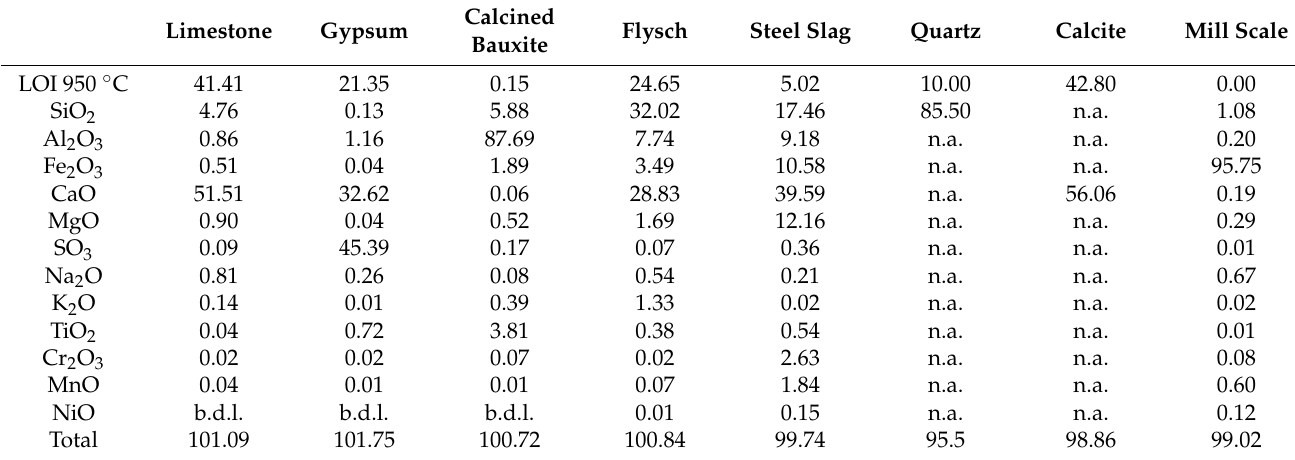
Table 1. Chemical composition of the raw materials (wt.%). The main oxides needed for the formulation of the raw mixtures were determined by wet chemistry, while the minor components were determined by X-ray fluorescence spectrometry (WDXRF, Thermo Scientific ARL PERFORM’X, Thermo Fisher Scientific, MA, USA; fused beads, UniQuant program).